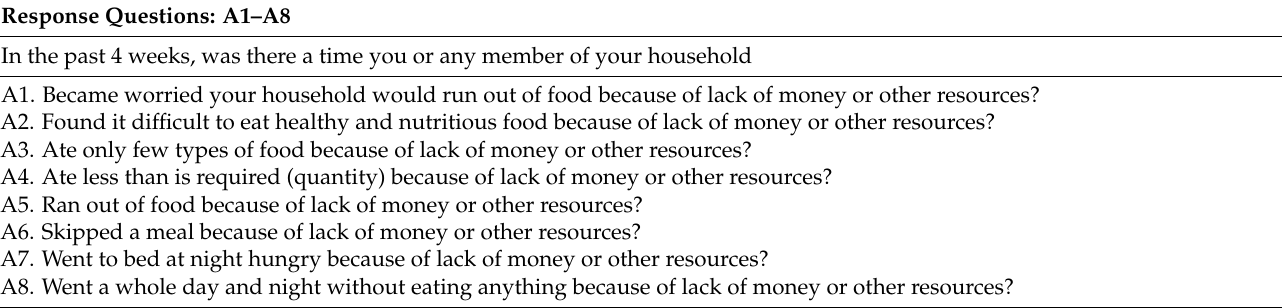
Table 1. Questions that make up the food insecurity experience